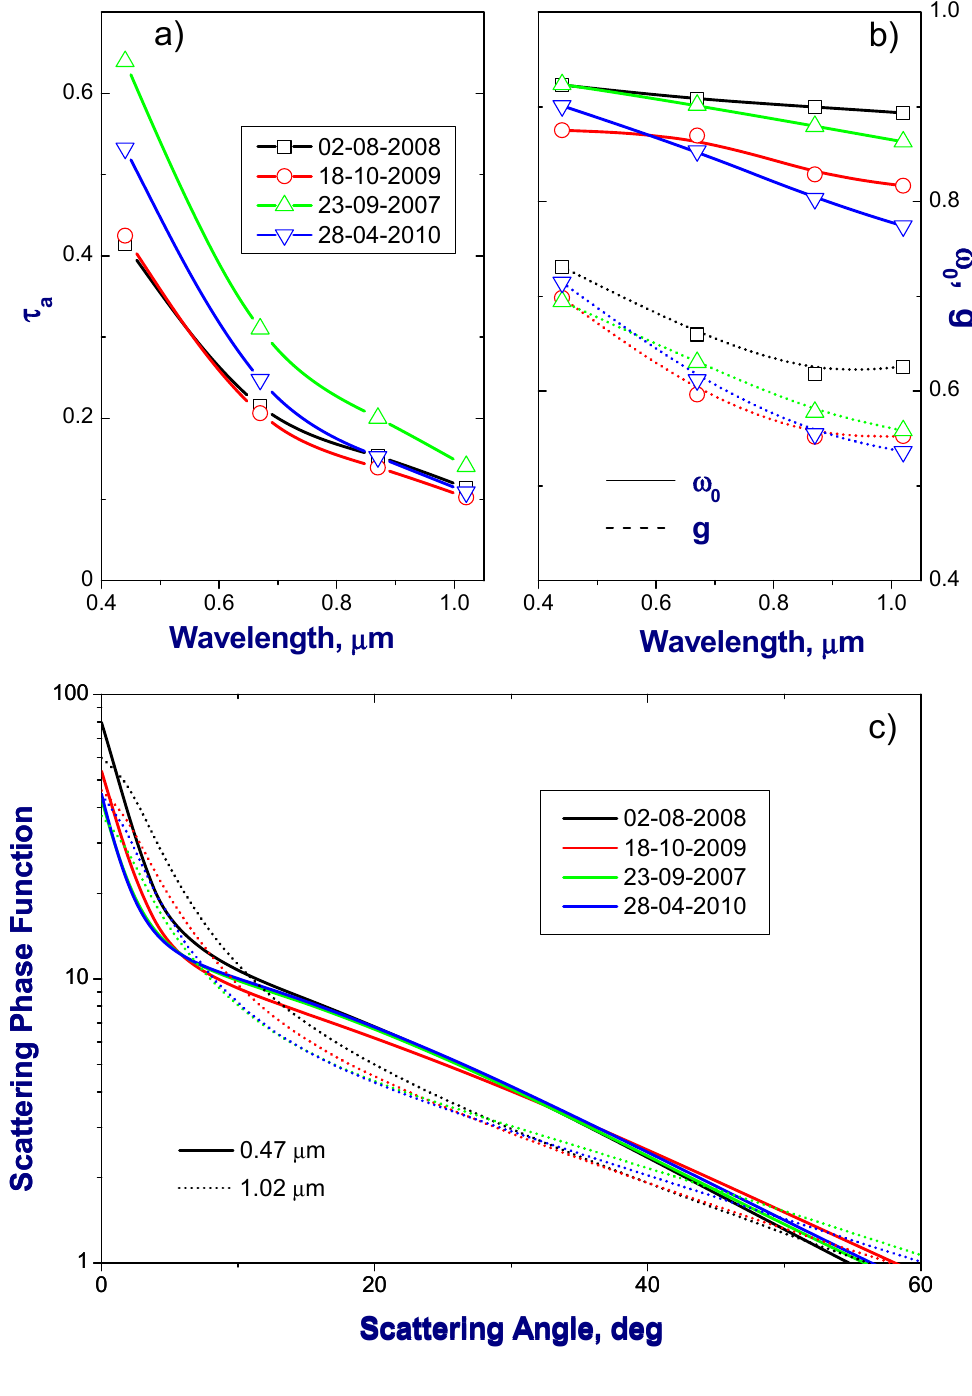
Figure 3. The aerosol optical depth ( a ), single-scattering albedo and asymmetry factor ( b ), and scattering phase function ( c ) as part of the AERONET operational product for the selected four days. These aerosol optical properties are considered as “true” optical properties in our sensitivity